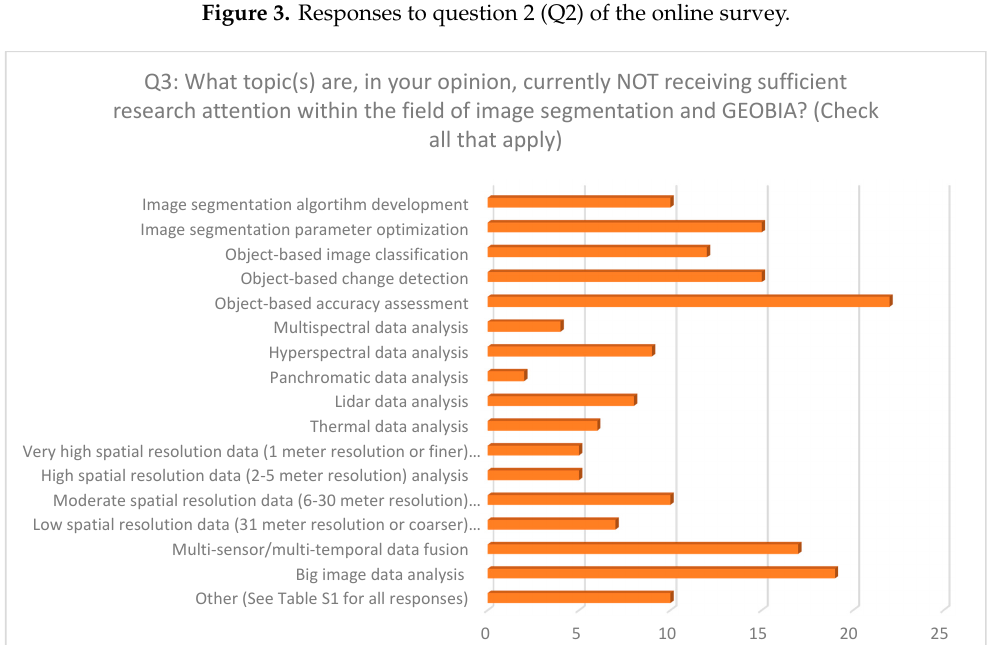
Figure 4. Responses to question 3 (Q3) of the online survey.